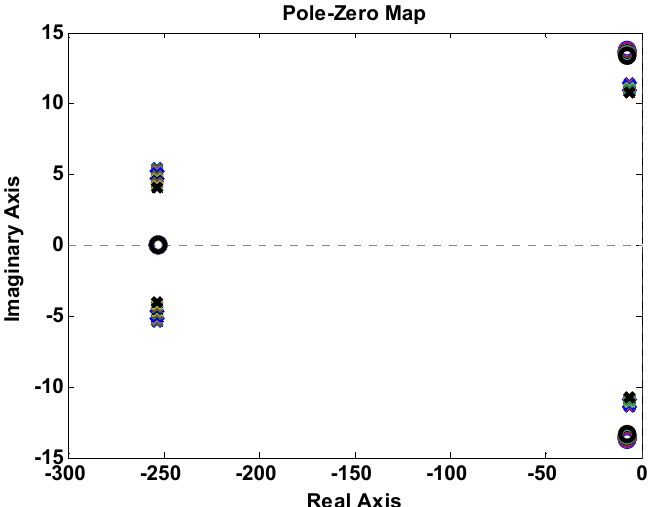
Figure 2. Poles and zeros of 𝐺 (cid:3104)(cid:2870)(cid:2870)(cid:4593) (𝑠) during the motoring mode of operation at low speed (20 rpm) and zero feedback gains ( K 1 = K 2 = 0).